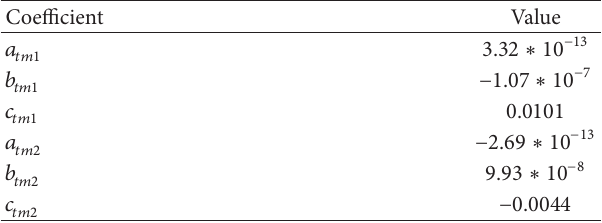
Table 3: Coefficient values of function 𝐴 𝑡 .